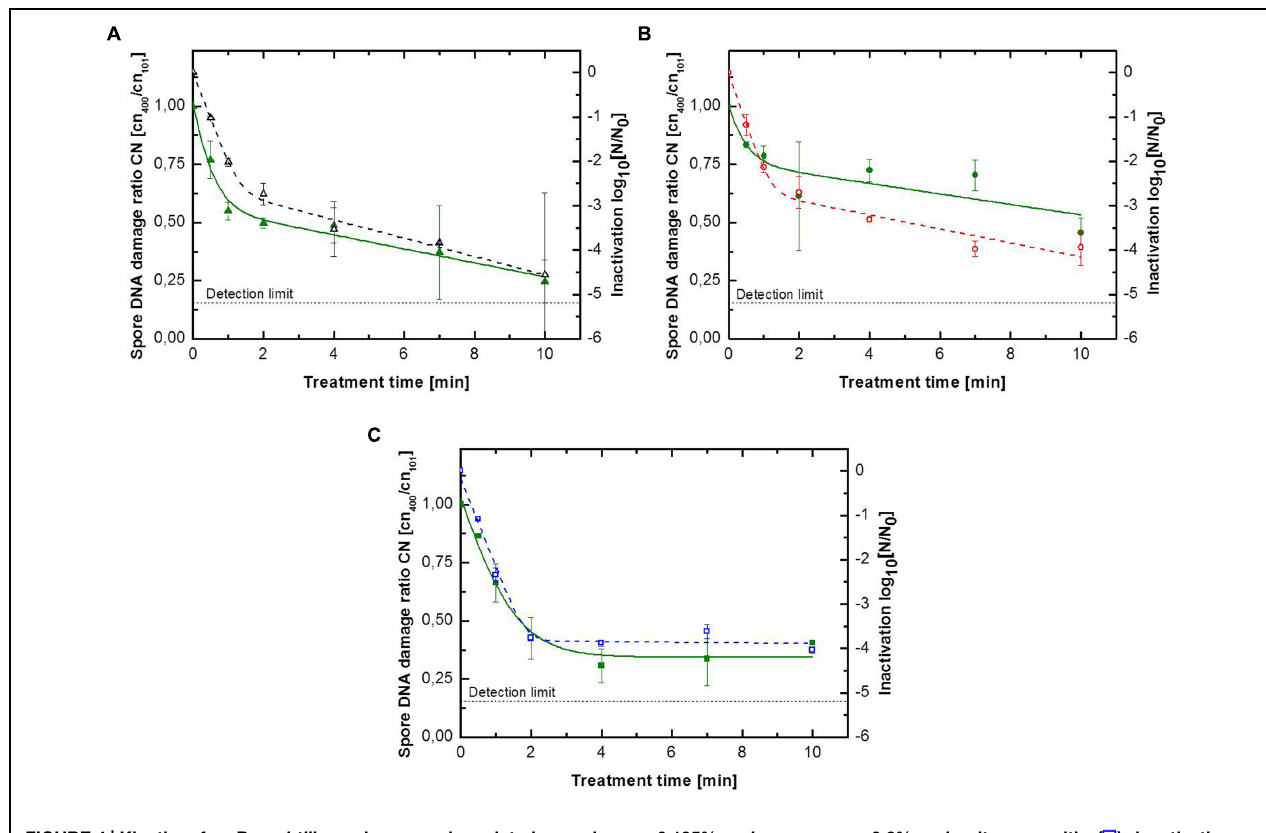
FIGURE 4 | Kinetics for B. subtilis endospores inoculated on glass beads for (A) pure argon with ( (cid:3) ) inactivation and ( (cid:3) )endospore DNA damage ratio, (B) argon + 0.135% vol. oxygen with ( (cid:4) ) inactivation and ( • )endospore DNA damage ratio, (C) argon +